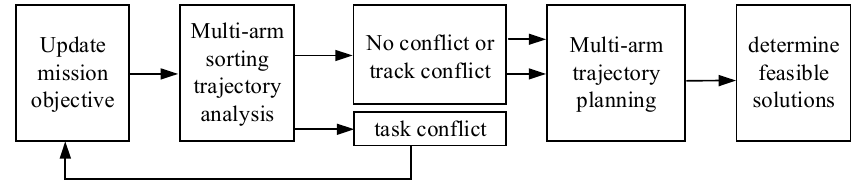
Figure 7. Multi-arm collaborative process.